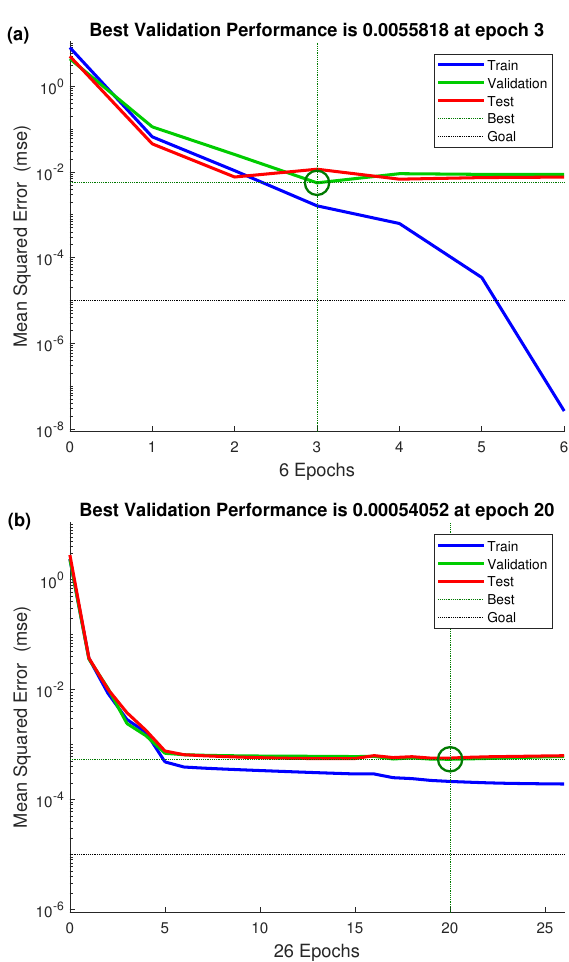
Figure 10. The evolution of loss function with respect to epochs. The MLP surrogate models are trained by ( a ) 100 samples and ( b ) 500 samples,